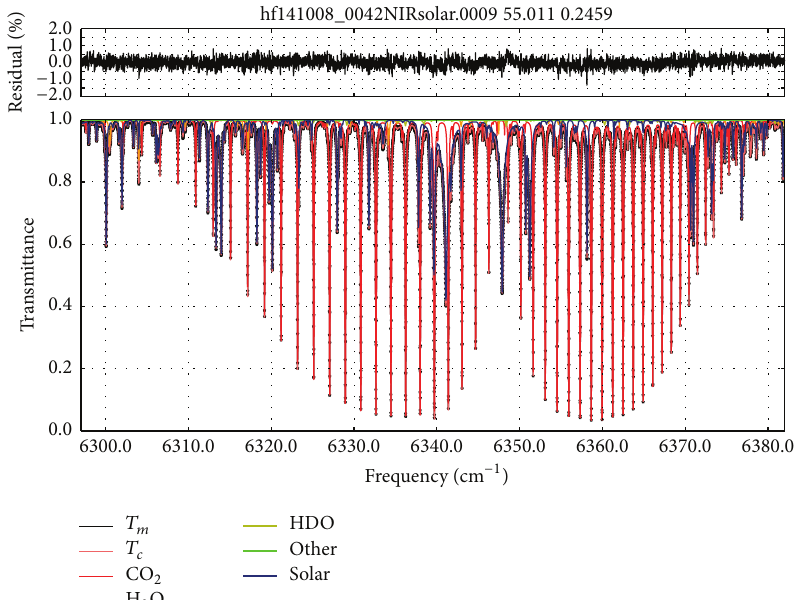
Figure 2: CO 2 spectral fitting within 6339 cm −1 window: the spectrum was recorded on October 8, 2014, 0:47 (UTC). Black lines are the measurements, orange lines are the fitted transmittance, and contributions from individual gases are shown in color. Fitting residuals ( 𝑇 𝑚 −𝑇 𝑐 ) for CO 2 are